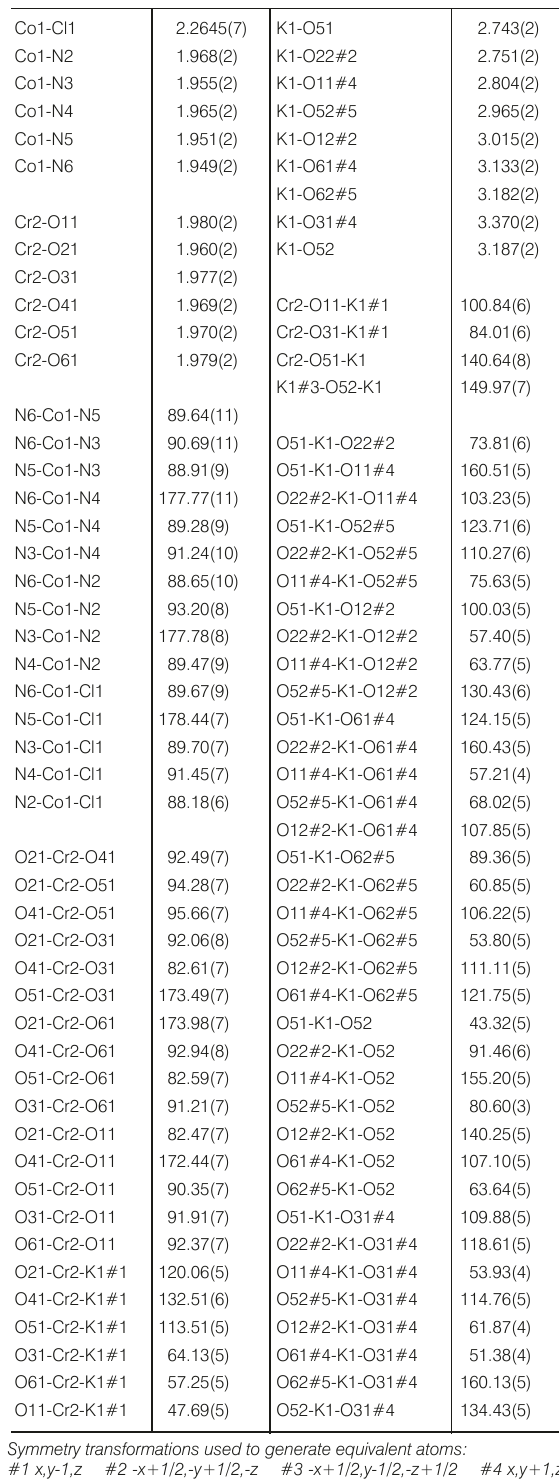
Table 2. Selected bond lengths and distances [Å], and angles [deg] for [CoCl(NH